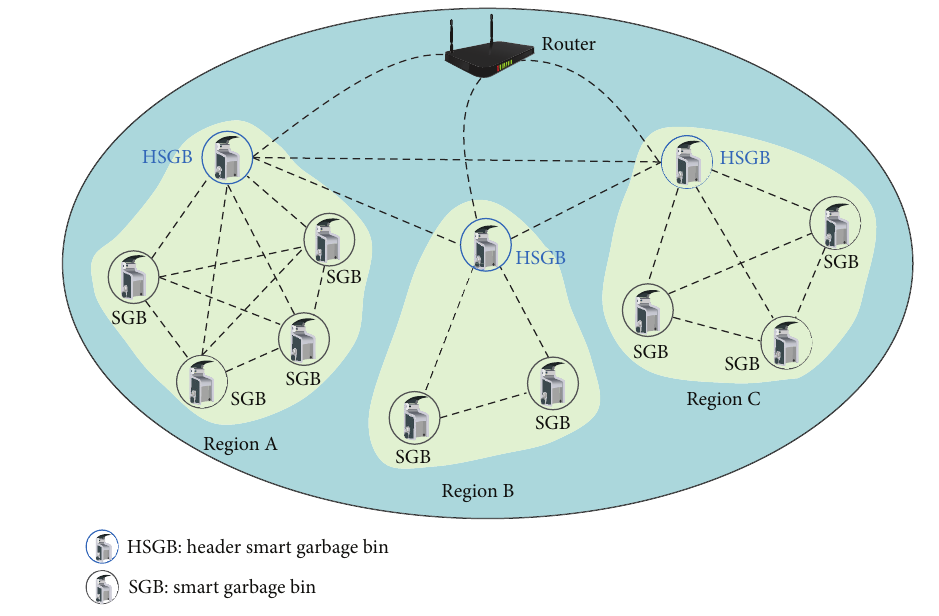
Figure 2: Network topology of smart garbage